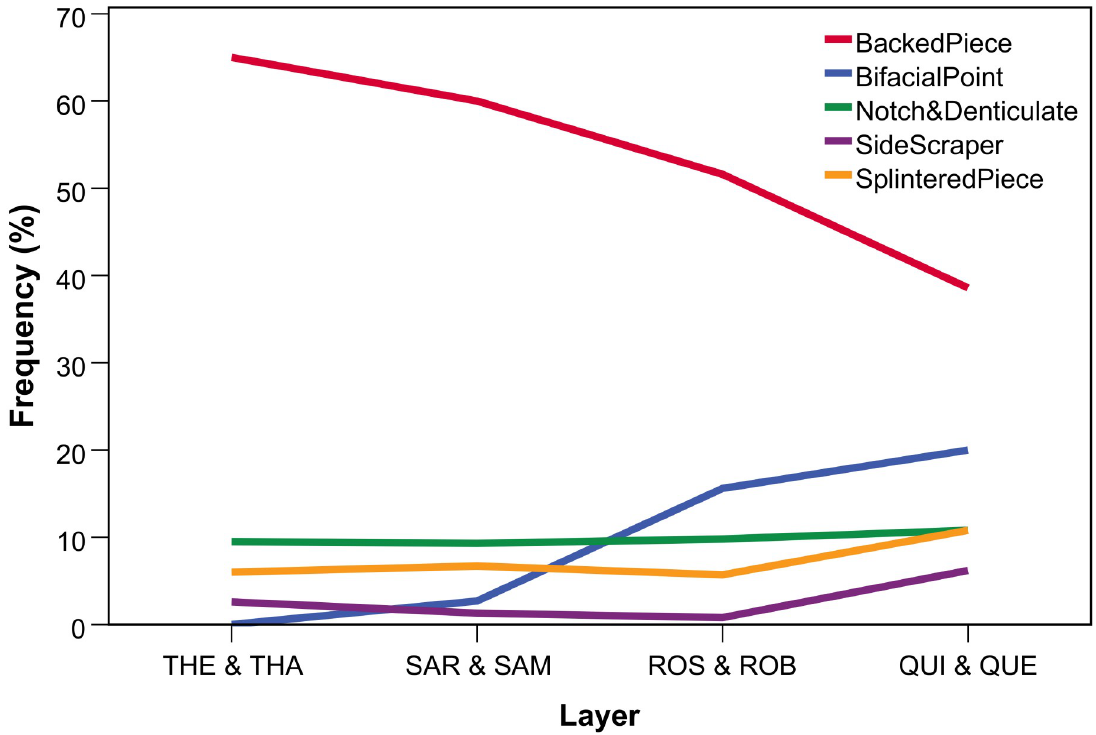
Fig 7. Diachronic variation of classic tool types throughout the HP at